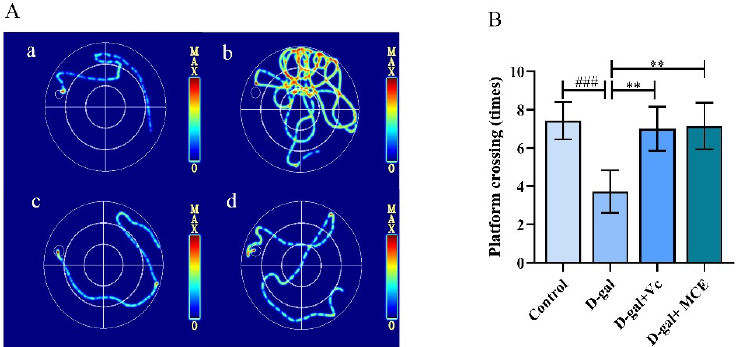
Figure 4. Heat maps of spatial navigation in MWM test ( A ): control group ( a ), D -gal group ( b ), D -gal + Vc group ( c ), D -gal + MCE group ( d ); and platform crossing (times) of spatial trial in MWM test ( B ). Data were reported as the mean ± S.D. of 20 mice in each group. ### p < 0.001 vs. control group; ** p < 0.01 vs. D -gal group.